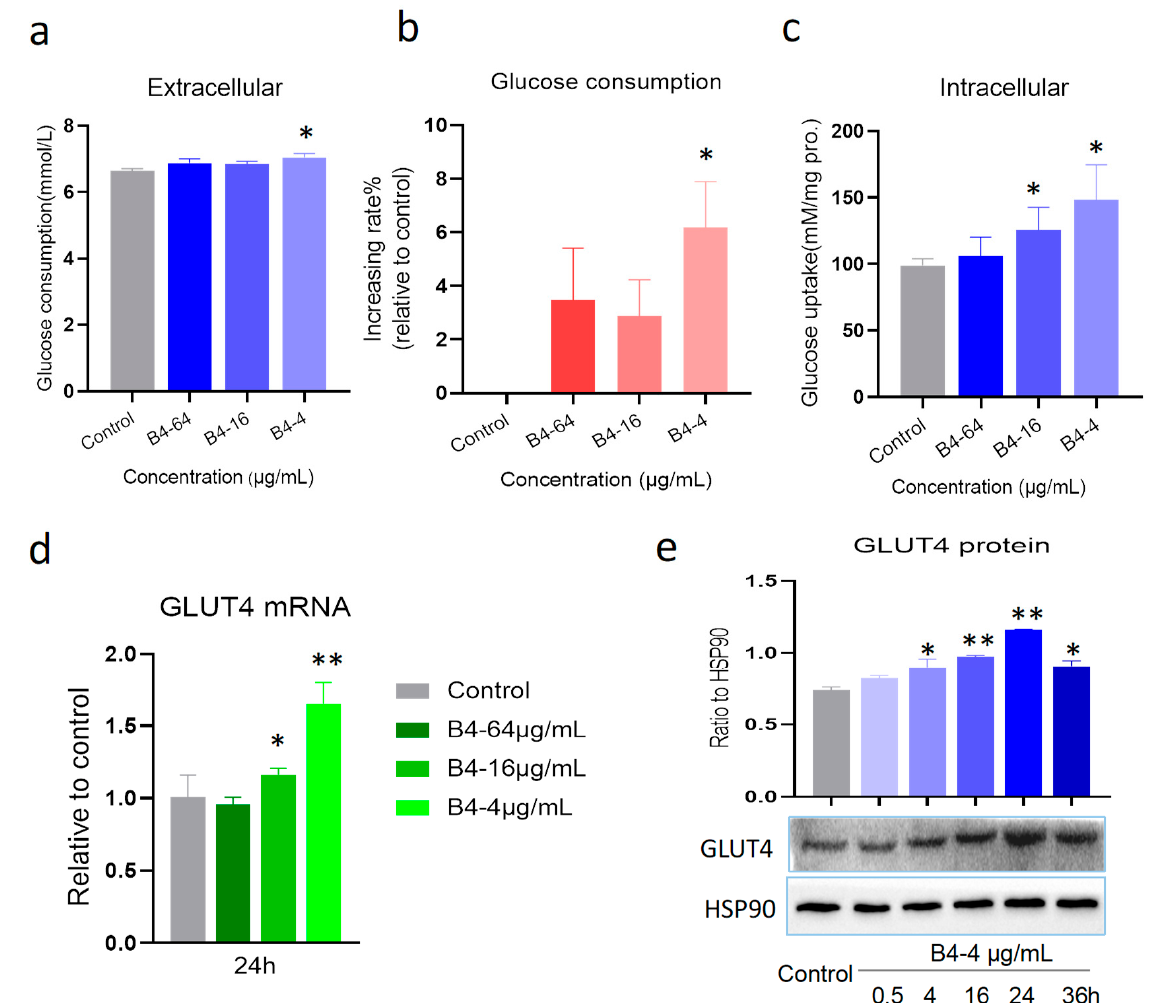
Figure 5. The glucose utilization and GLUT4 expression in L6 cells. ( a ) Glucose consumption; ( b ) Increasing rate of glucose consumption; ( c ) Glucose uptake; ( d ) mRNA expression of GLUT4; ( e ) Protein expression of GLUT4. * p < 0.05, ** p < 0.01 vs. normal group. Data represent the mean ± standard error of three separate experiments.